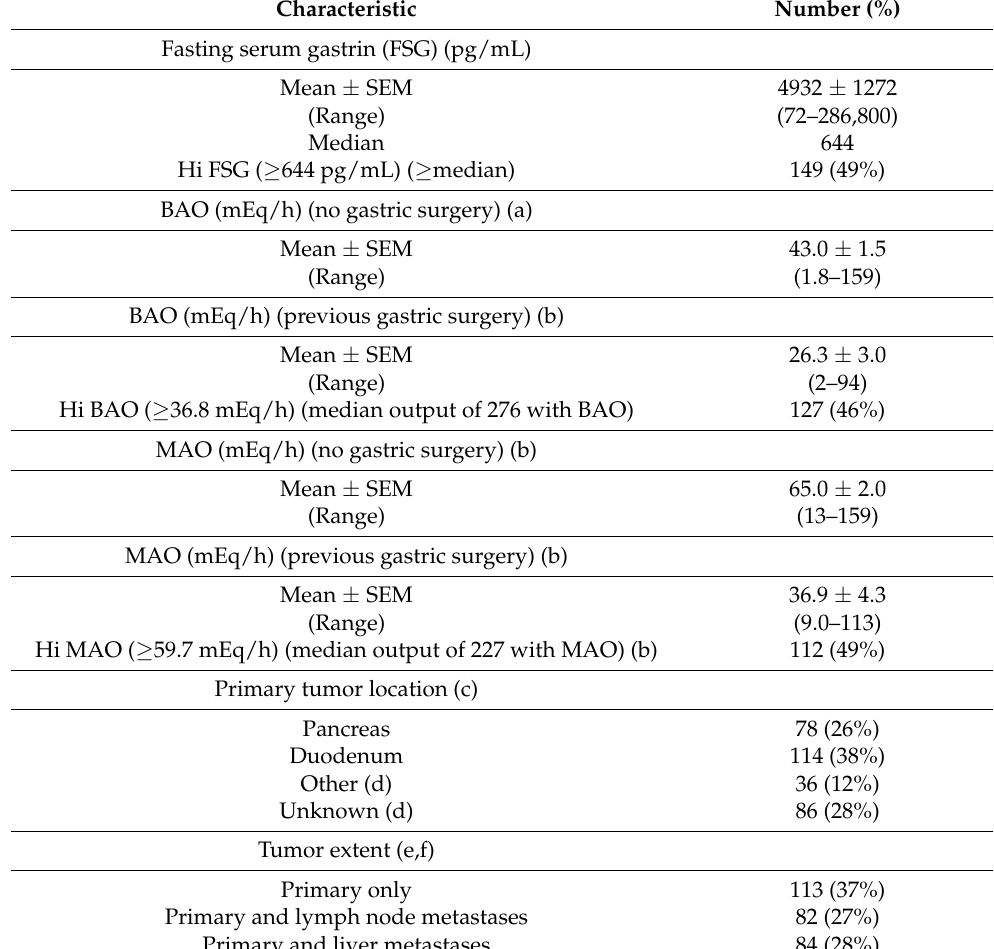
Table 2. Patient laboratory/tumor